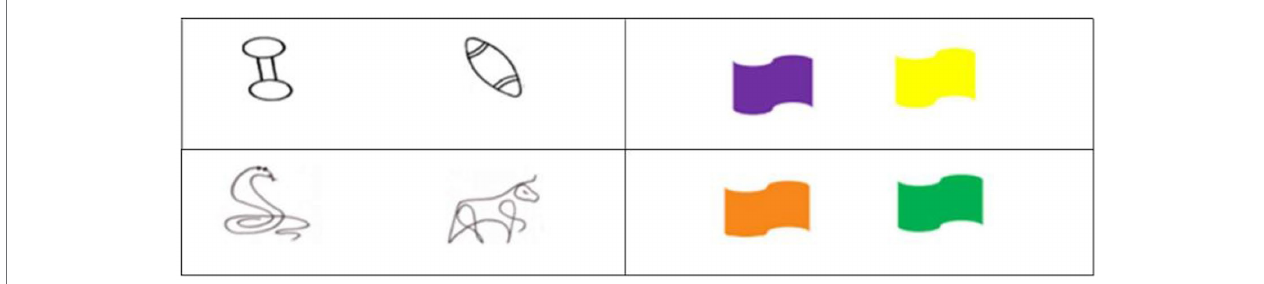
FIGURE 3 | Objects of preference and flags used in Task